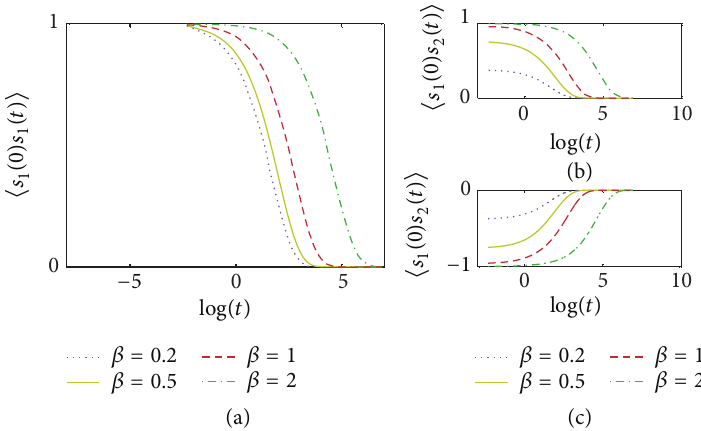
Figure 1: Temperature dependent (a) autocorrelation functions, (b) cross-correlation functions for 𝐽 = 1 , and (c) cross-correlation functions for 𝐽 = −1 , for an interacting pair of fluctuators, shown for 𝛾 1 = 0.1 and 𝛾 2 = 0.2 . ⟨𝑓󵄨󵄨󵄨󵄨󵄨𝜎 (2) = W (𝑡)𝜎 (1) W 𝑧 𝑧